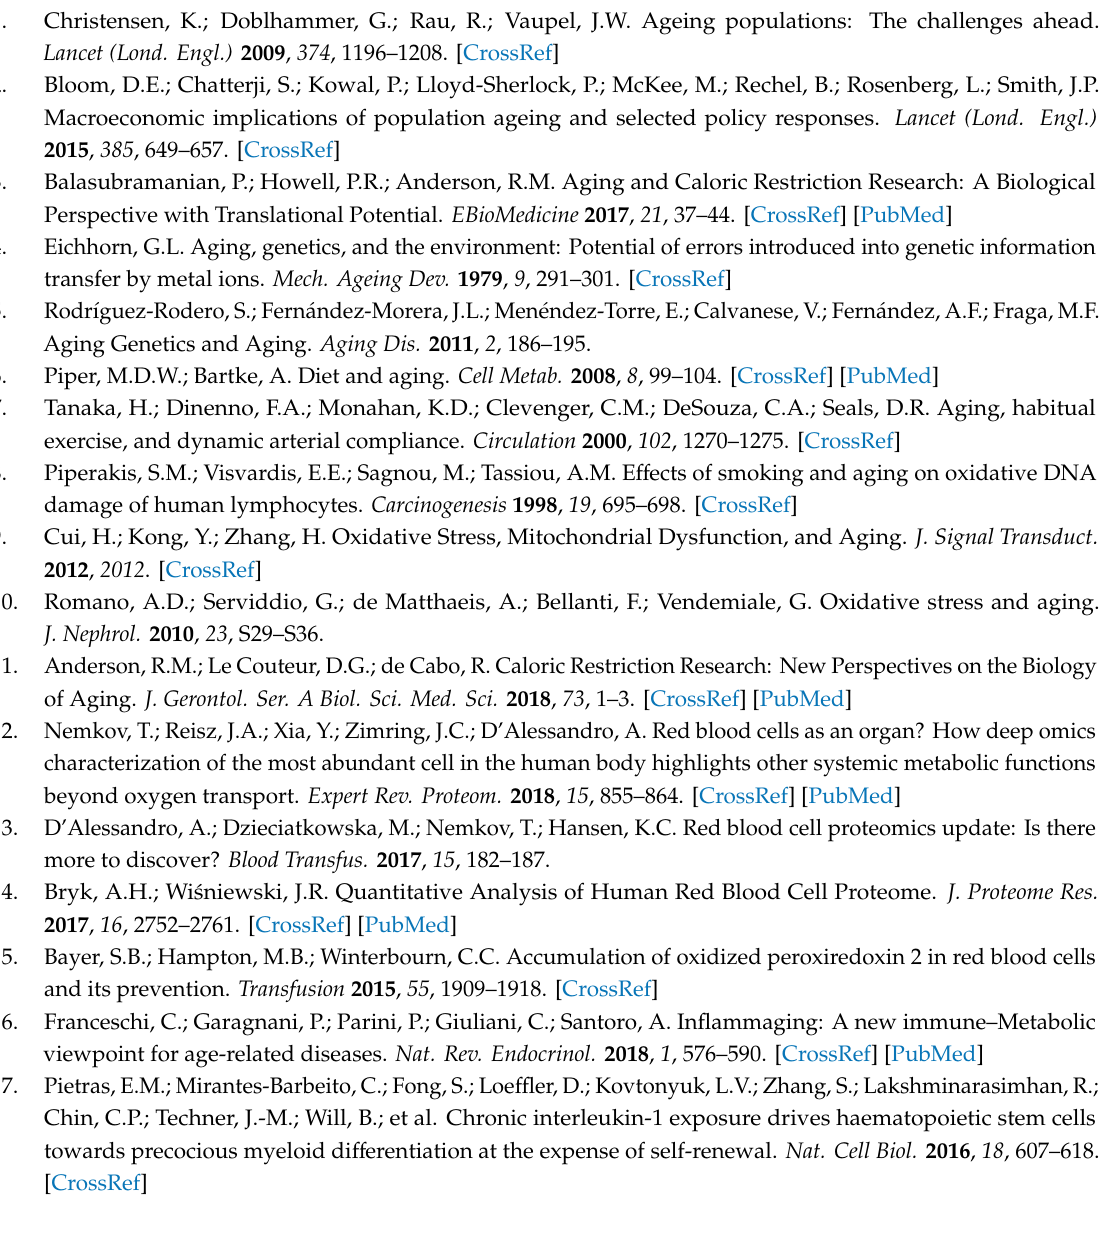
Table S1: Metabolomics report for aging mouse RBCs; Table S2: Metabolomics report for parabiotic mouse RBCs; Table S3: Proteomics report for aging and parabiotic mouse